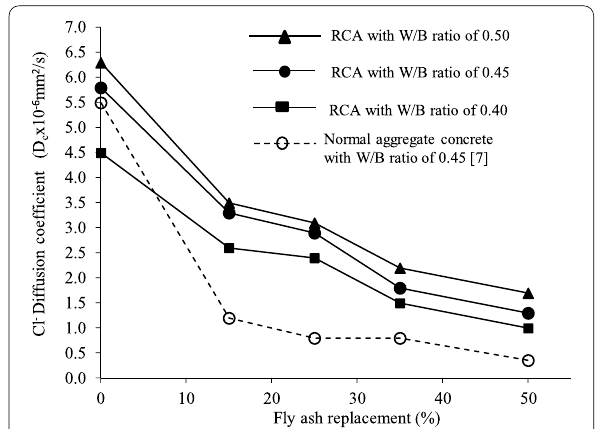
Fig. 6 Effect of fly ash on D c of RCA concrete after being exposed to seawater for 7 years.